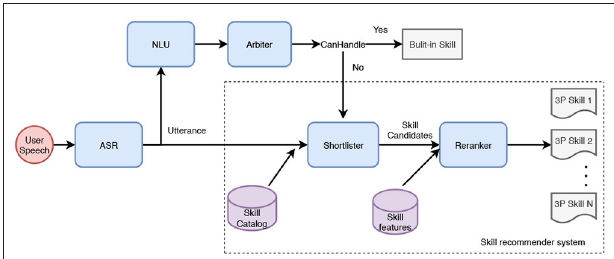
FIGURE 2 | A overview of skill recommender